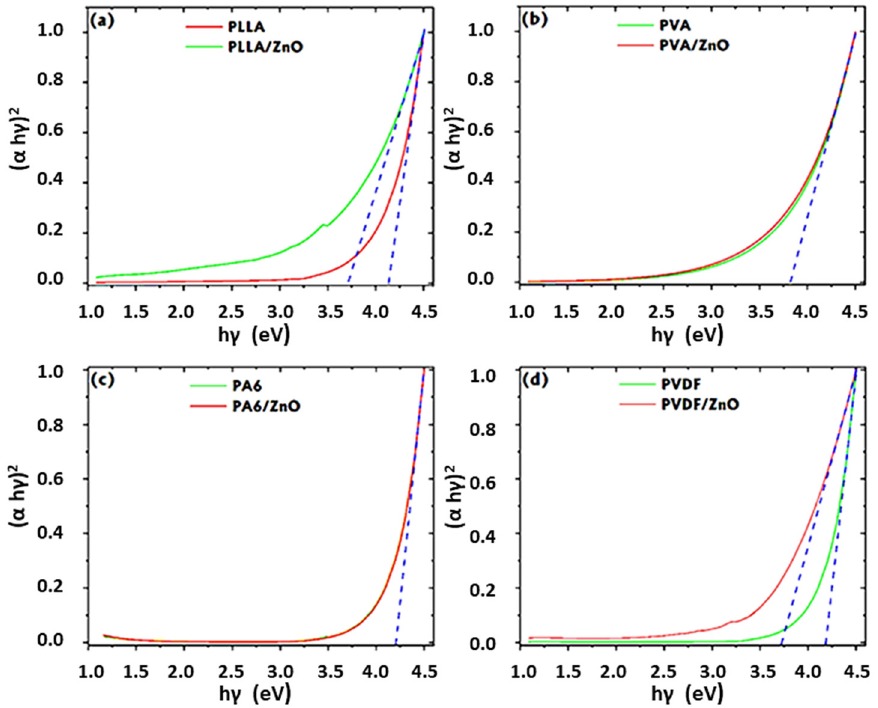
Figure 4. Tauc plots of ( a ) the PLLA and PLLA/ZnO nanofibers, ( b ) PVA and PVA/ZnO nanofibers, / ZnO nanofibers, ( d ) PVDF and PVDF / ZnO ( c ) PA6 and PA6/ZnO nanofibers, ( d ) PVDF and PVDF/ZnO nanofibers. ( c ) PA6 and PA6